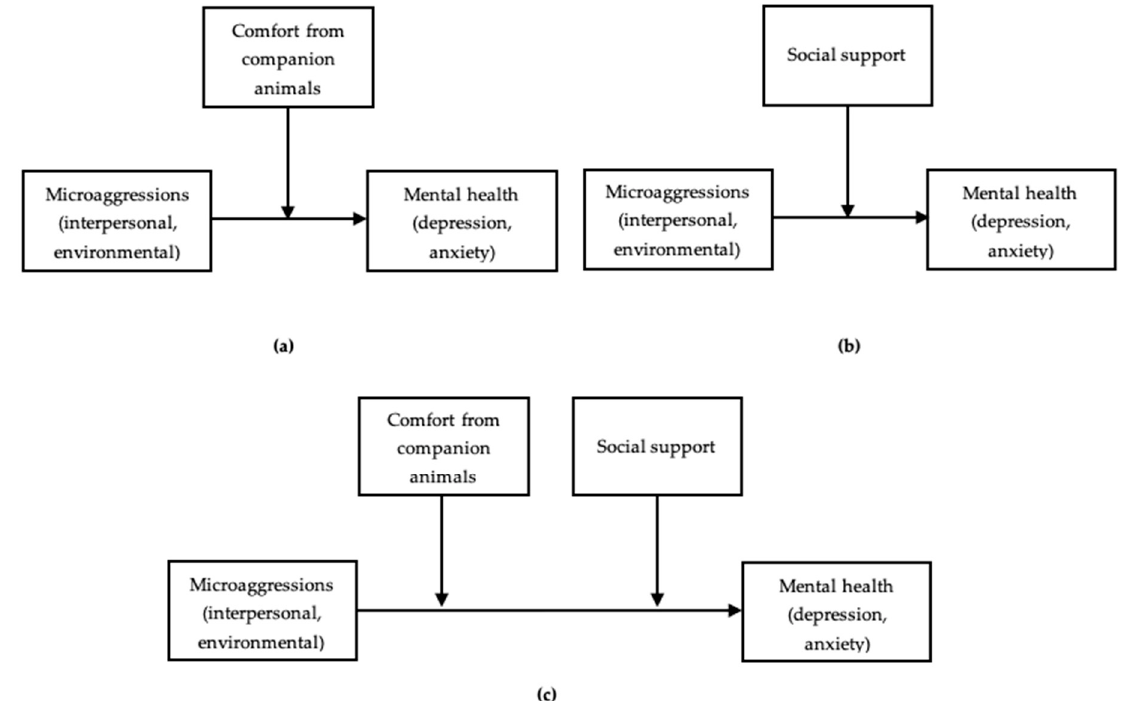
Figure 1. Conceptual models for moderation analyses. Covariates are not shown in the figures for clarity. ( a ) Simple moderation model with comfort from companion animals as the moderating variable; ( b ) simple moderation model with social support as the moderating variable; ( c ) multiple moderation model.